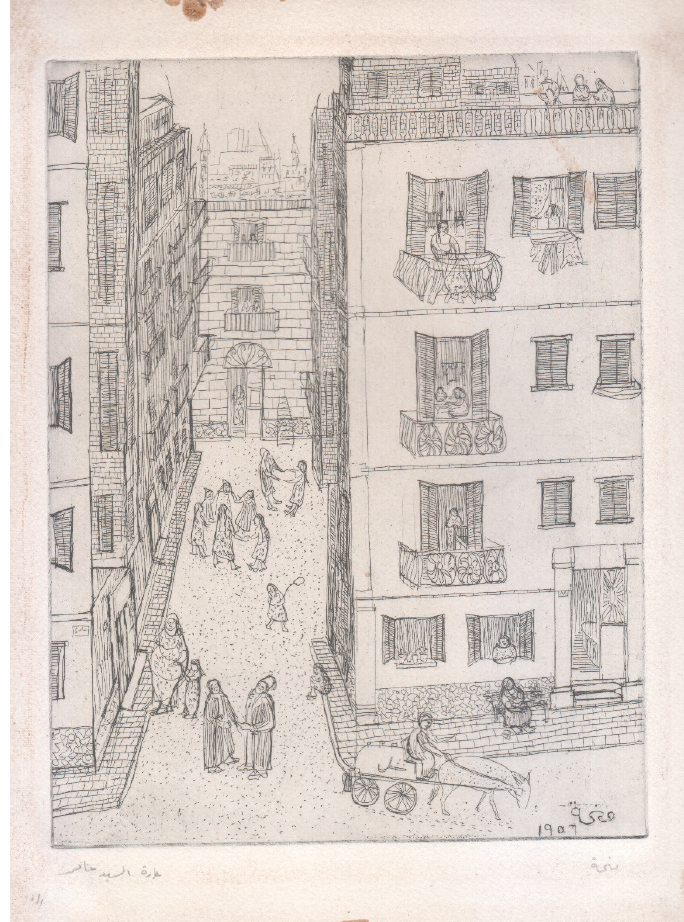
Figure 9. Menhat Helmy, The Alley (1956). Etching. Courtesy of estate of Menhat